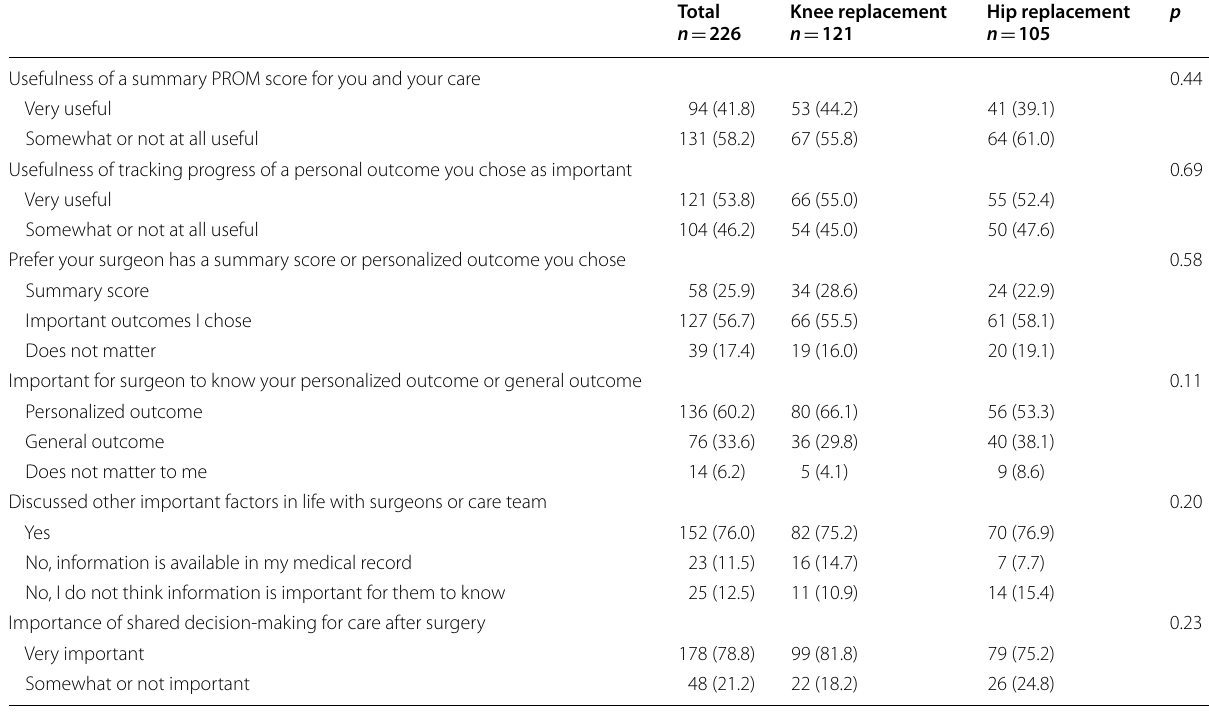
Table 4 Perceptions of personalized outcomes, standardized PROMs and shared decision